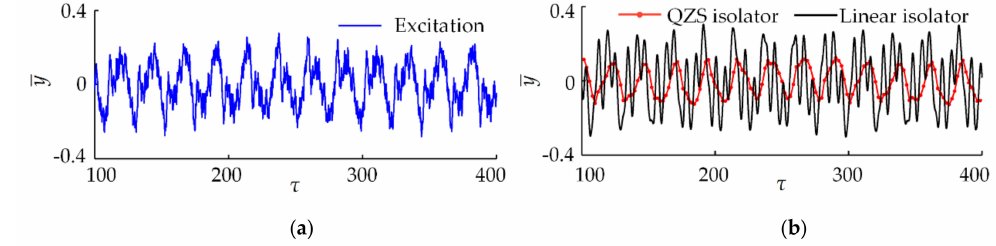
Figure 17. Time history under random excitation. ( a ) Displacement excitation; ( b ) displacement responses of QZS and equivalent linear